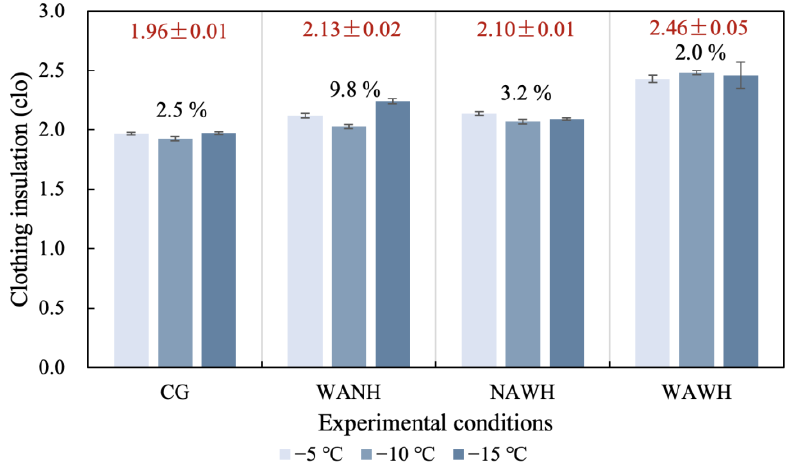
Figure 6. I cl of four garments at different T a .